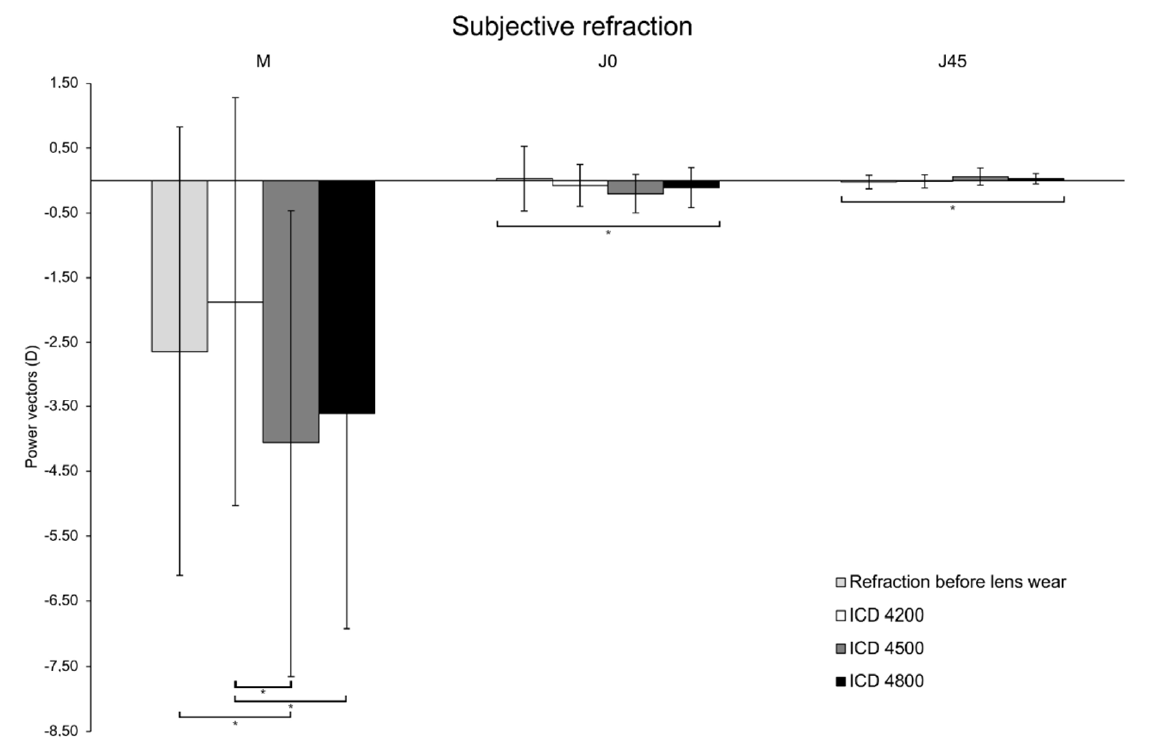
Figure 3. Subjective refraction obtained in before lens wear (light grey) and with the different scleral lenses (ScCL) of sagittal heights of 4200 µm (white), 4500 µm (grey) and 4800 µm (black). * p < 0.05; Friedman test. Error bars represent SD.